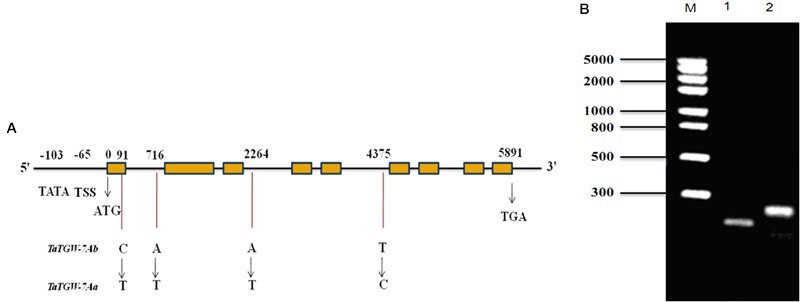
(A) Structure and allelic variations of TaTGW-7A gene. Four SNPs are present between TaTGW-7Aa and TaTGW-7Ab. The CAPS marker (TGW7A) is developed based on the SNP in the first exon (C-T). The TATA-box, transcription start site (TSS), start codon (ATG) and stop codon (TGA) are shown. (B) The CAPS marker is used for discriminating TaTGW-7Aa and TaTGW-7Ab on 2.0% agarose gel. M: marker; 1: Jing 411 (TaTGW-7Aa); 2: Hongmangchun 21 (TaTGW-7Ab).